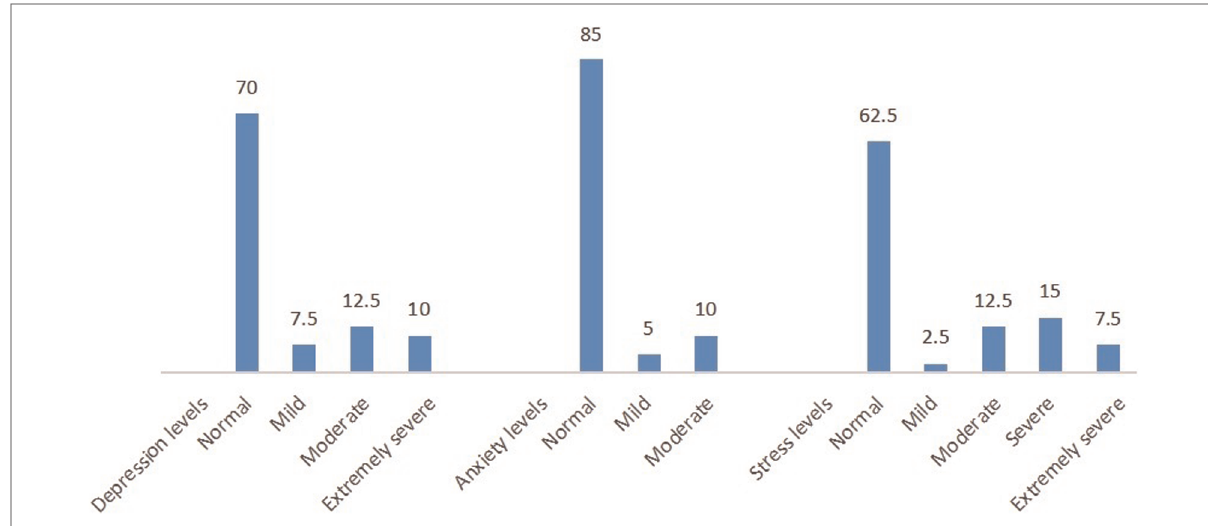
FIGURE 2 Percentage distribution of the participants according to depression, anxiety and stress status based on the DASS21 scale classi fi cation.